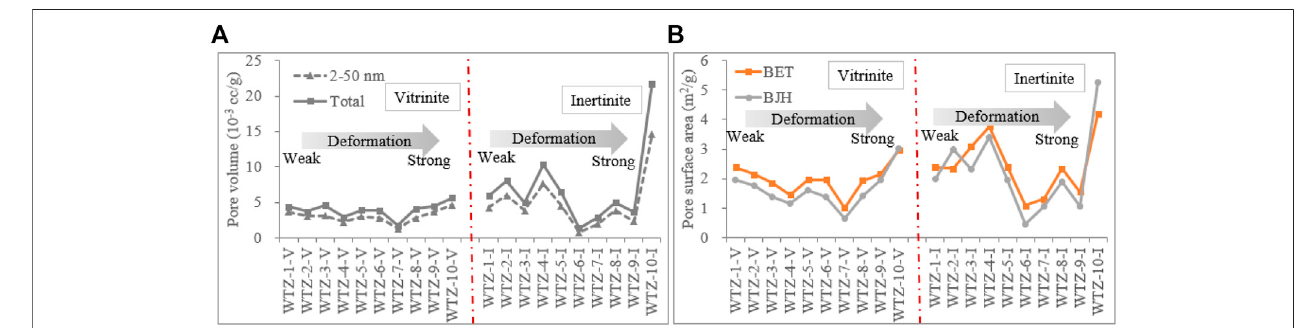
Frontiers in Earth Science |